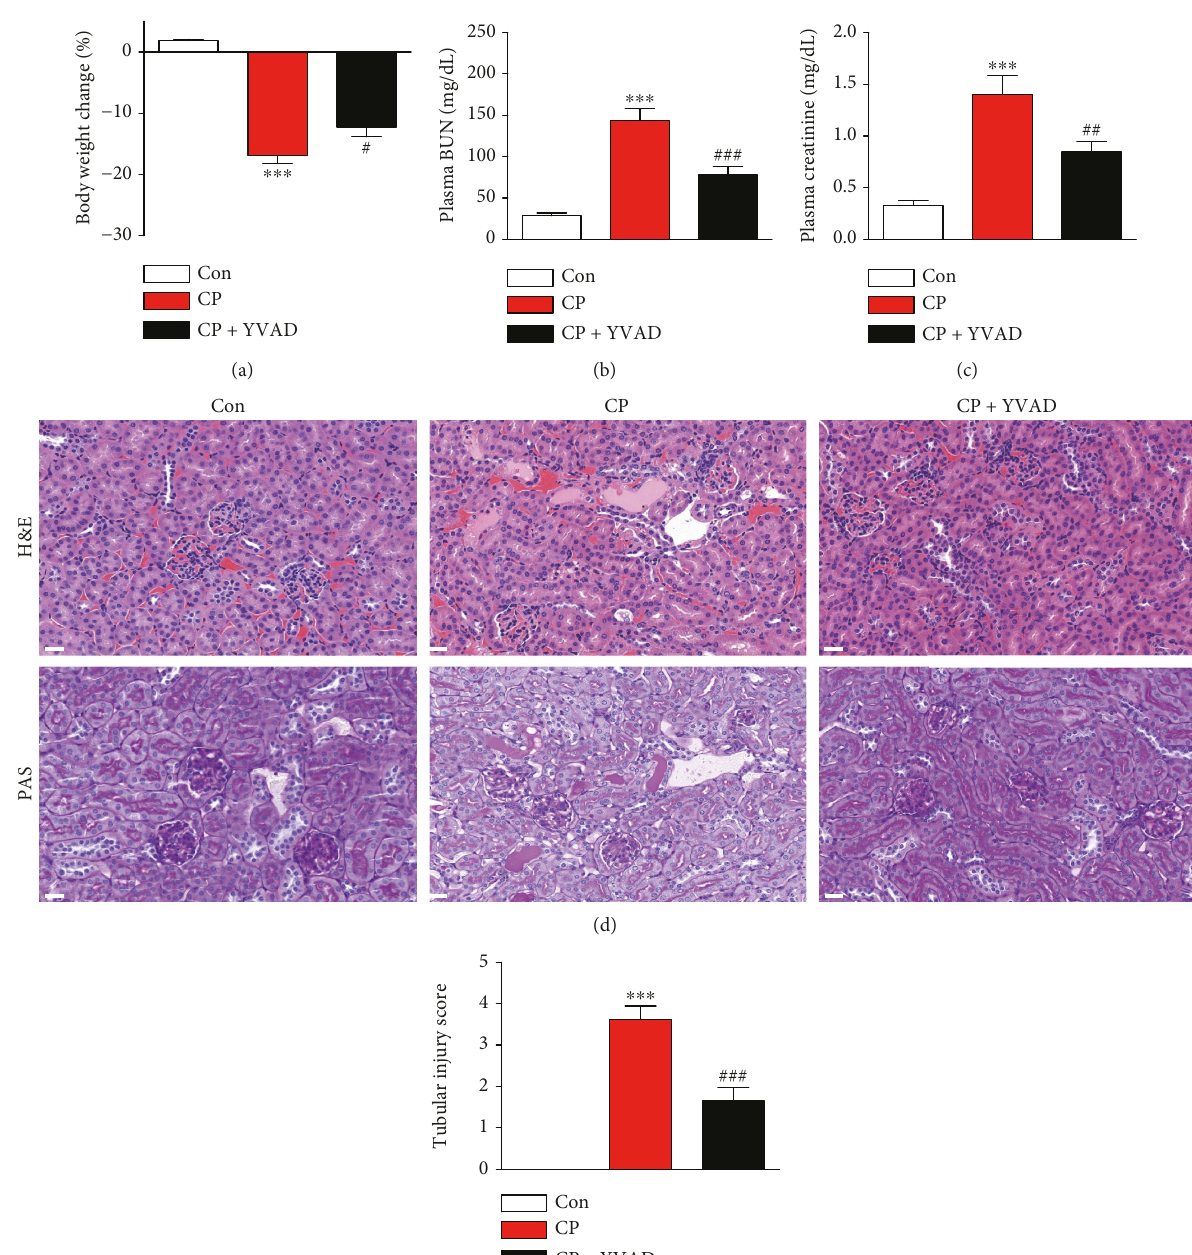
Figure 1: E ff ects of Ac-YVAD-cmk on body weight, renal function, and renal histology in cisplatin-treated mice. Mice were injected intraperitoneally with 10mg/kg AC-YYAD-cmk for 3 days, starting 1h prior to a single dose of cisplatin (15 mg/kg). (a) Percent change in body weight. (b) Plasma blood urea nitrogen (BUN). (c) Plasma creatinine. (d) Representative images of hematoxylin and eosin (H&E) and periodic acid-Schi ff (PAS) staining on kidney sections. Scale bar: 25 μ m. (e) Tubular injury score. Con: control, CP: cisplatin, and CP +YVAD: cisplatin plus Ac-YVAD-cmk. n = 8 per group. All data are expressed as the mean ± SEM. ∗∗∗ P < 0 001 vs. Con. # P < 0 05 , ## P < 0 01 , and ### P < 0 001 vs.